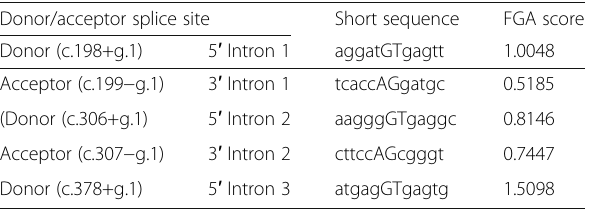
Table 2 The potential predicted 5 ′ and 3 ′ splice sites (GT-AG) in Buffalo CATH4 unspliced cDNA sequence Donor/acceptor splice site